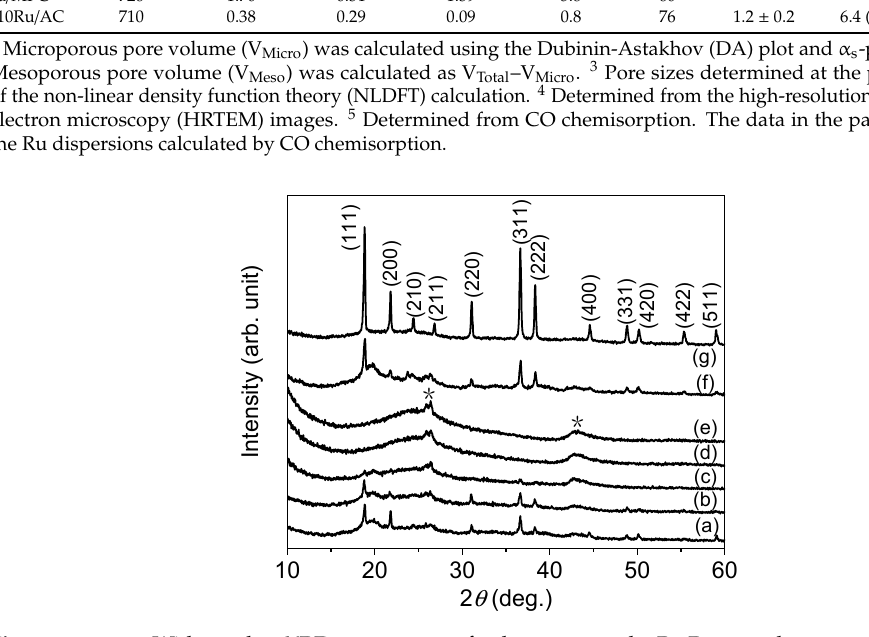
Table 1. The structural properties of the prepared Ba-Ru catalysts and reference materials.